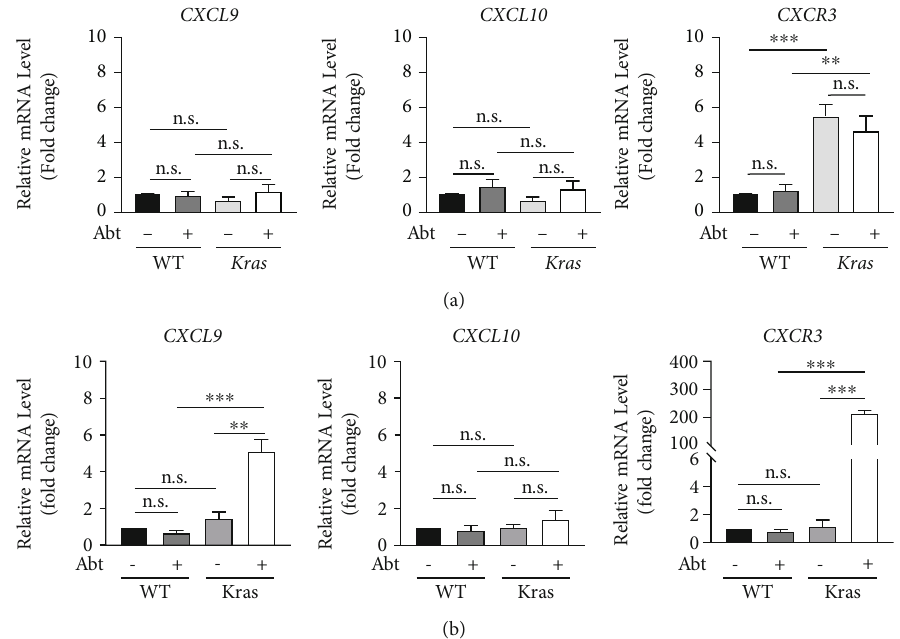
Figure 4: High expression of CXCL9 and CXCR3 in the lung of Abt- Kras mice. CXCL9, CXCL10, and CXCR3 mRNA levels in the lungs at stage 1 (a) and stage 3 (b) cancer were measured by real-time PCR, n = 4 – 5 . Data are presented as mean ± SEM . ∗∗ p < 0 : 01 and ∗∗∗ p < 0 : 001 . n.s.: not signi fi